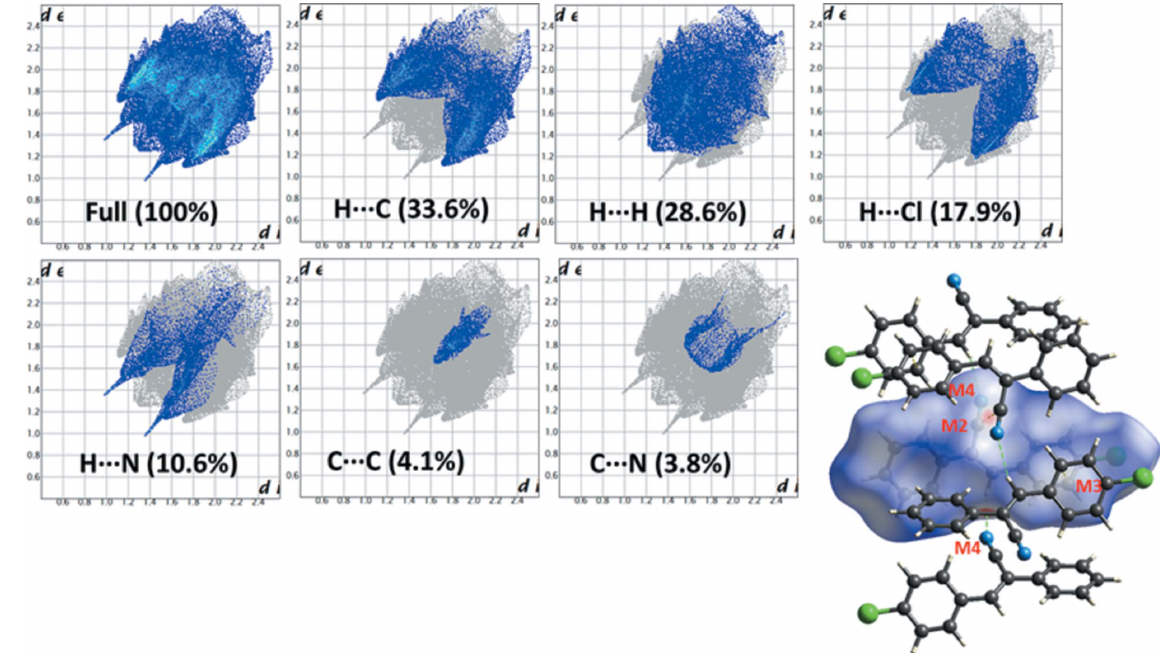
Figure 7 2D fingerprint plots for different intermolecular contacts and the Hirshfeld surface mapped over d norm to hightlight the short intermolecular contacts for the major disordered component of I